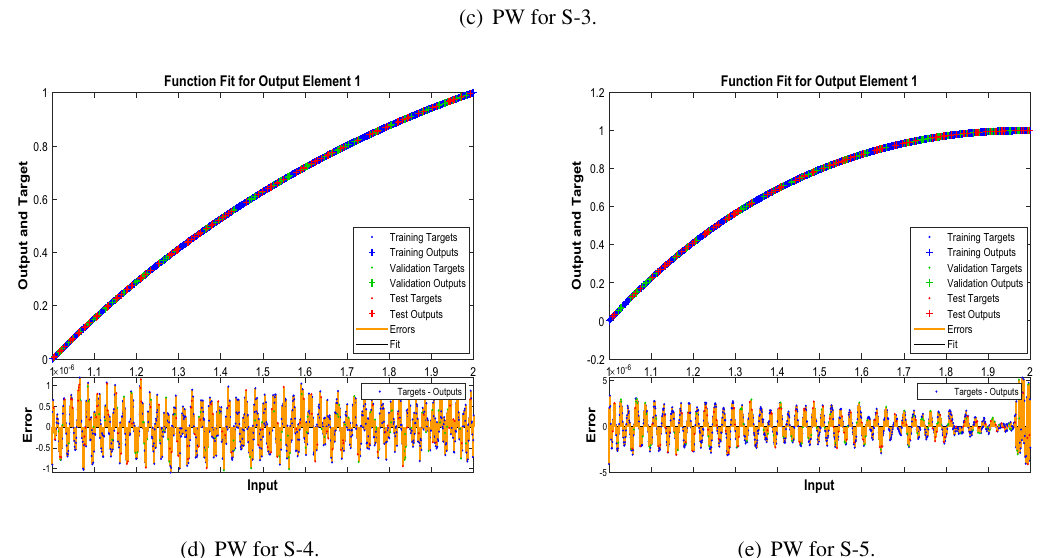
Figure 20. Reference solution comparison with LMA-TNN based performance view (PW) for case 4 in Reynolds